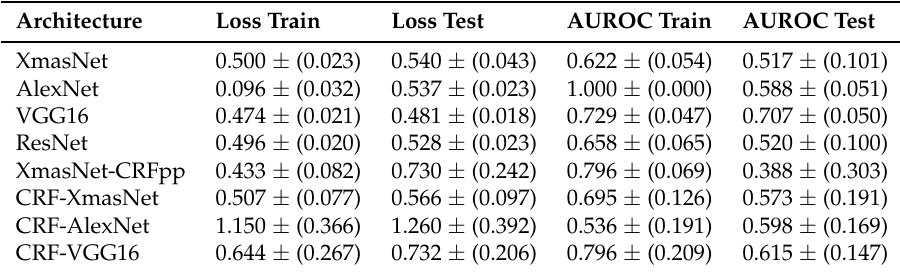
Table 6. Loss and AUROC values for each architecture. The average value (with standard deviation in parenthesis), obtained over 30 independent runs is